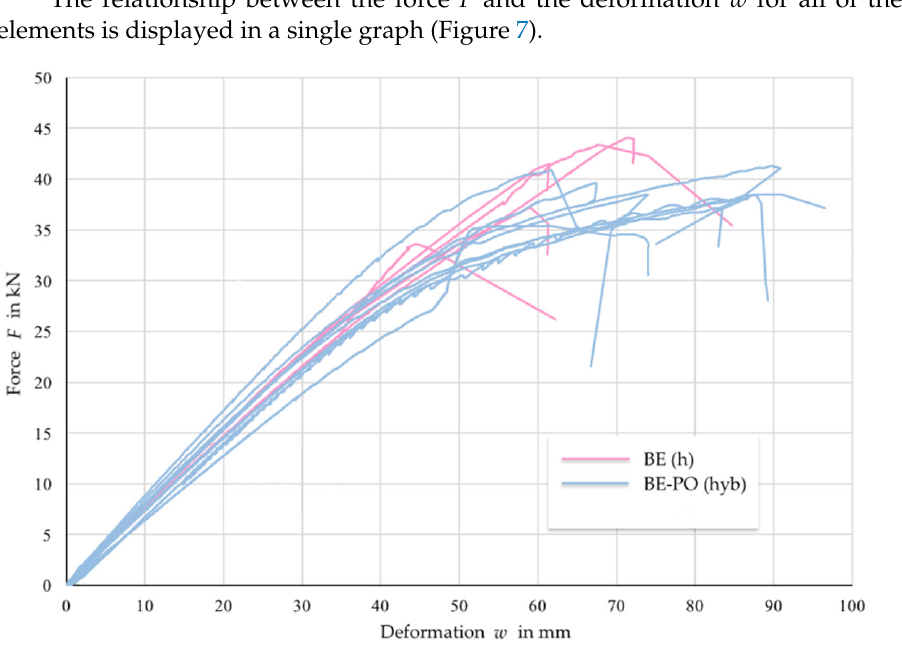
Figure 6. Arrangement of the test for strength and the modulus of elasticity in the lamellae bending test. Dimensions in mm.